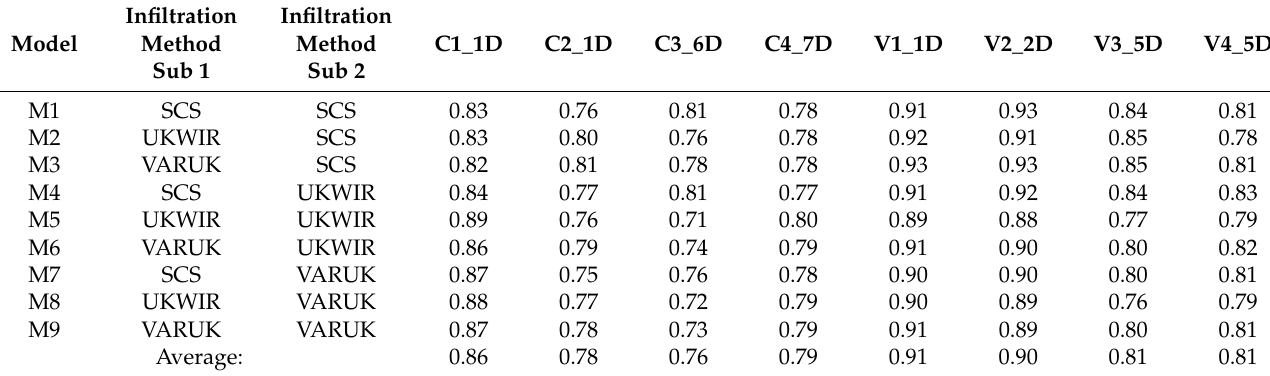
Table 6. Nash–Sutcliffe efficiency coefficient values for all models and modeled rainfall